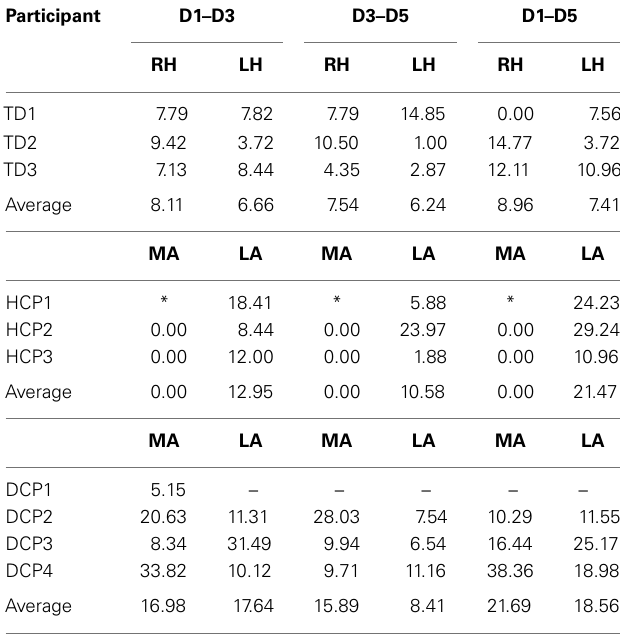
Table 2 | Euclidean distances (in millimeter) for activities in S1 .